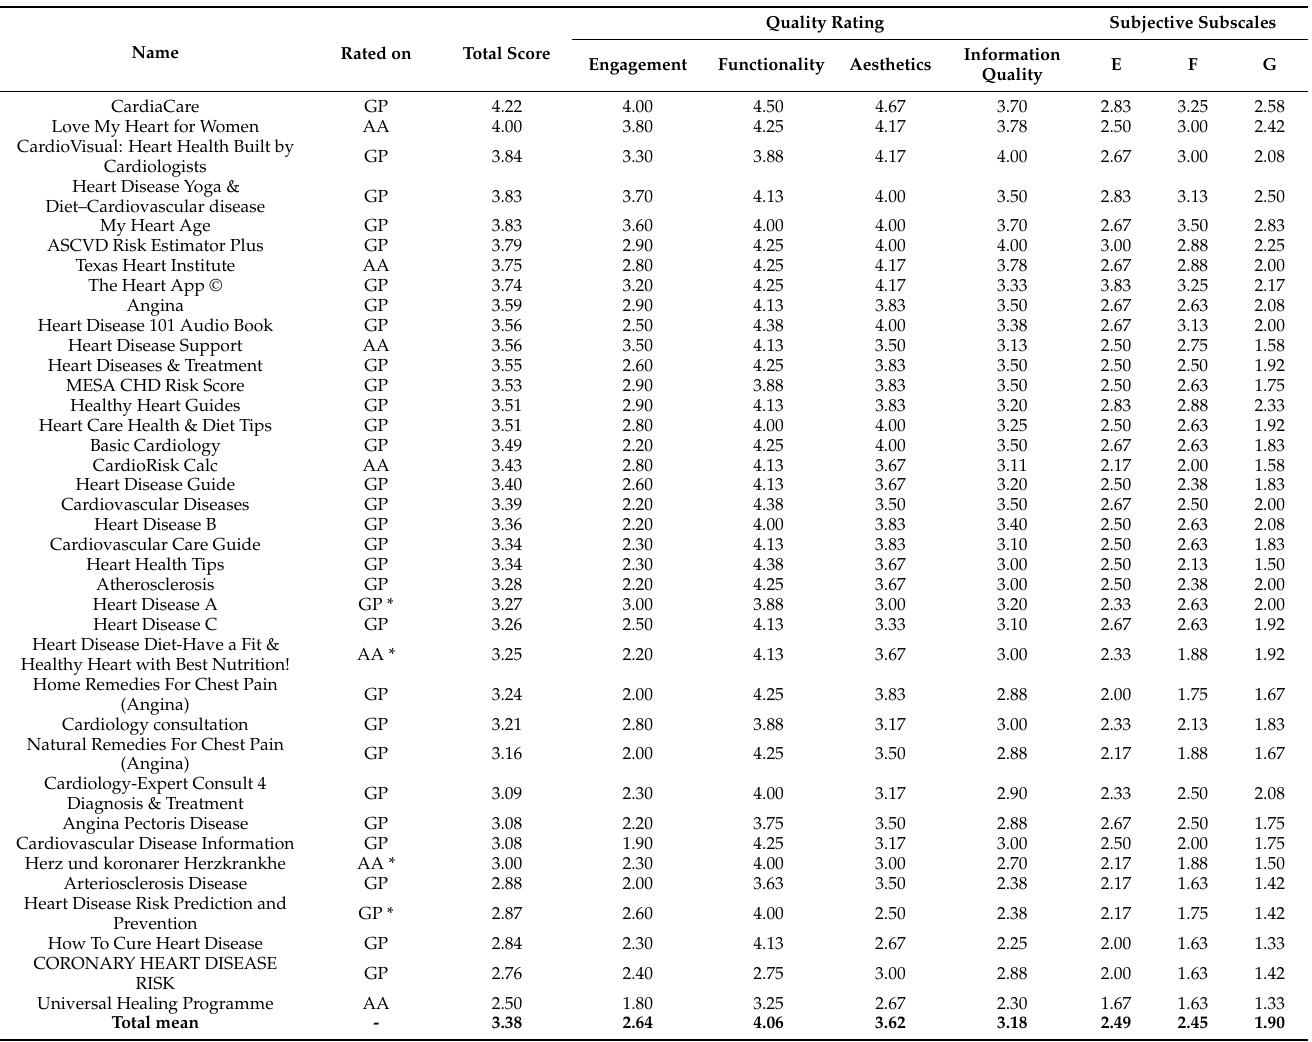
Table 2. Means of the MARS rating from highest to lowest total